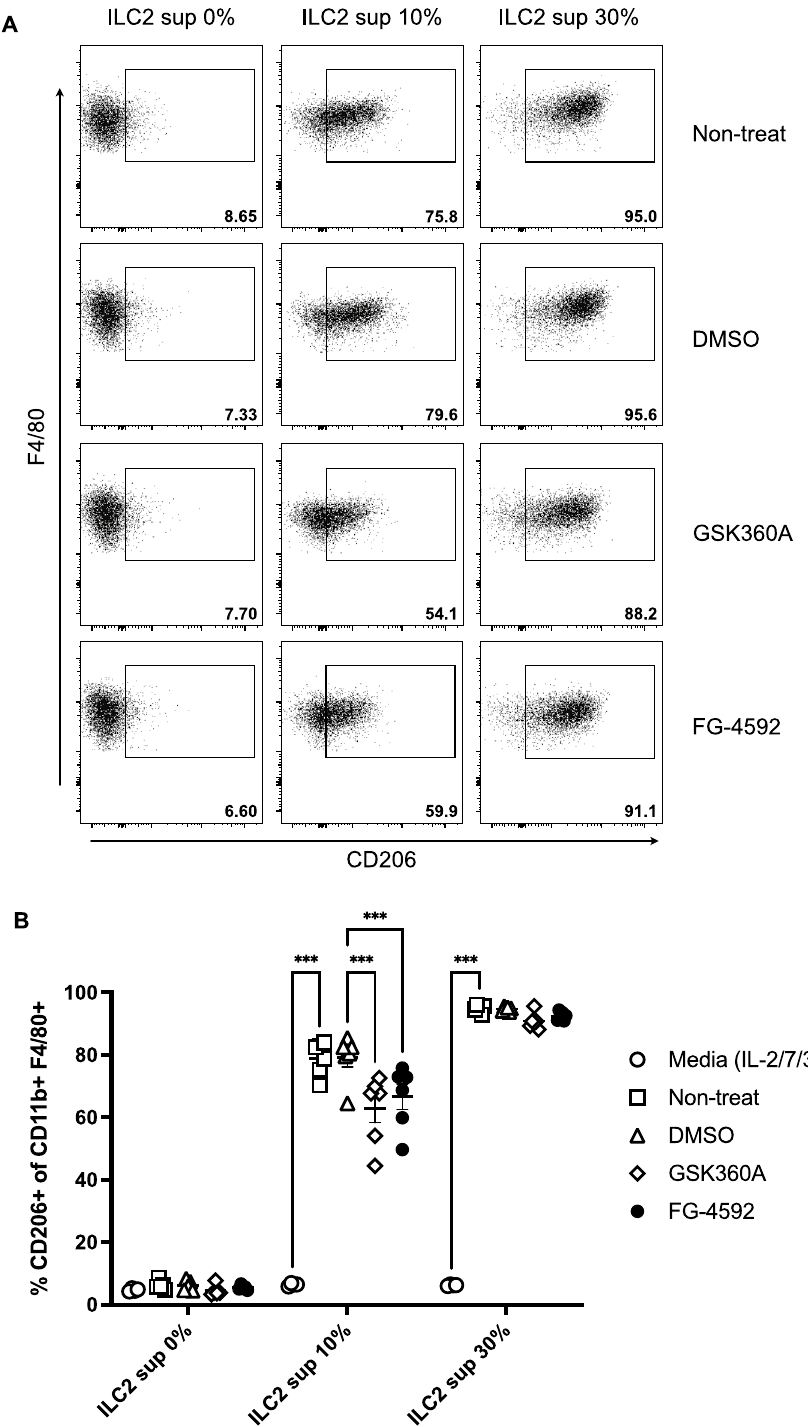
Figure 4. Decreased production of type 2 cytokines from kidney ILC2s treated with HIF-PHD inhibitors suppressed the polarization of M2 macrophages. BMDMs were cultured with culture supernatants of kidney ILC2s treated with HIF-PHD inhibitors. After 48 h of culture, the frequency of CD206 + M2 macrophages was analyzed by FACS. ( A ) Representative plots of CD206 + M2 macrophages induced by culture supernatants from ILC2s. ( B ) The graph shows the frequency of CD206 + M2 macrophages within the live CD11b + F4/80 + population. We used the pooled kidney from 6 mice as n = 1, and data shown are pooled from two (n = 6) independent experiments. Error bars show SEM. *** p <